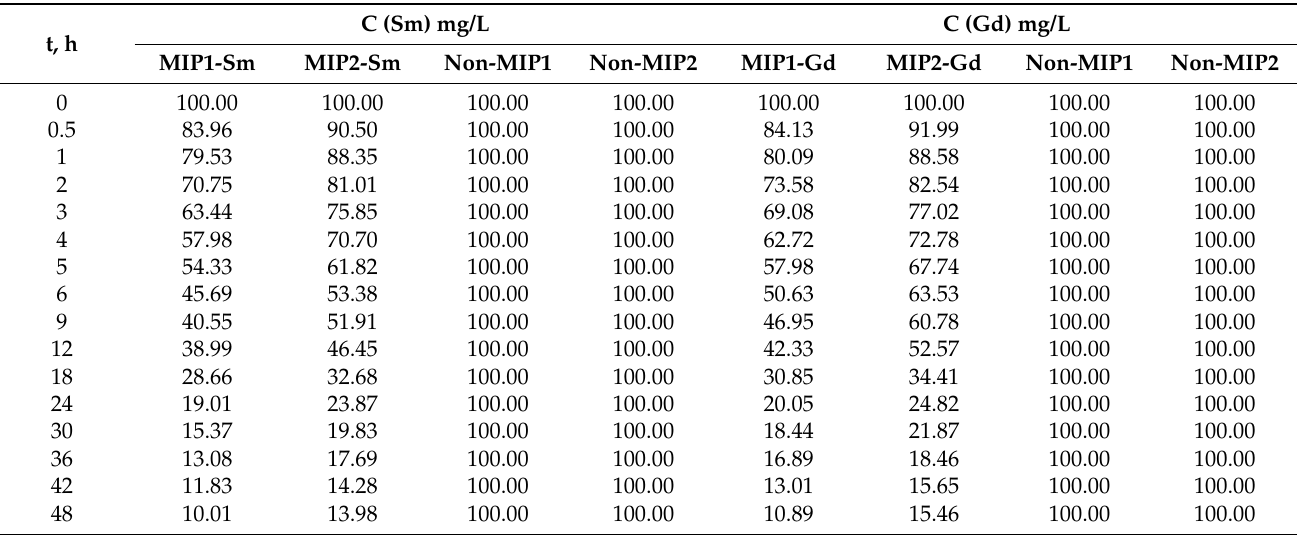
Table 1. Decreasing values of samarium and gadolinium concentrations via imprinted structures MIP1,